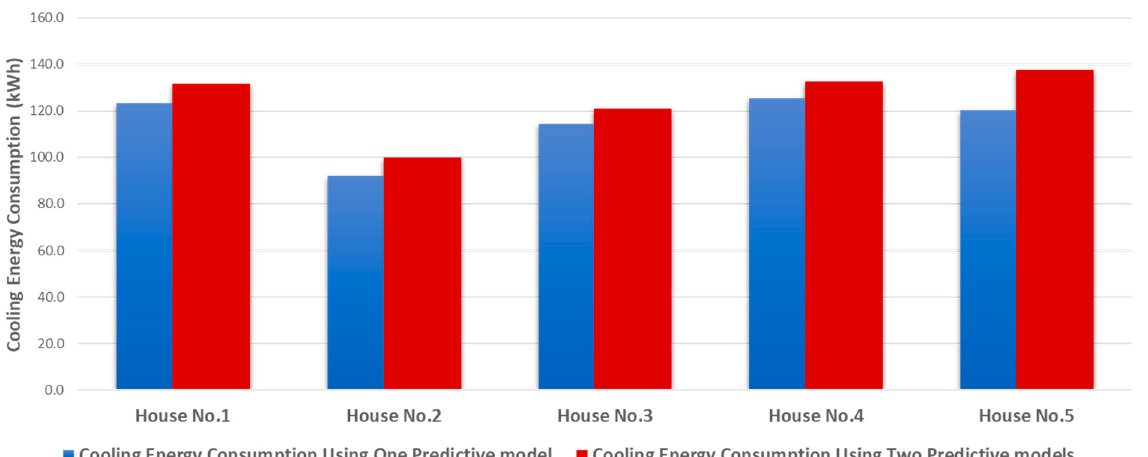
Figure 5. Cooling energy consumption for the residences described in Table 1 for two cases: (1) PMV control with one predictive model (temperature) (Alhamayani et al. [14]) and (2) PMV control with two predictive models (relative humidity and temperature).